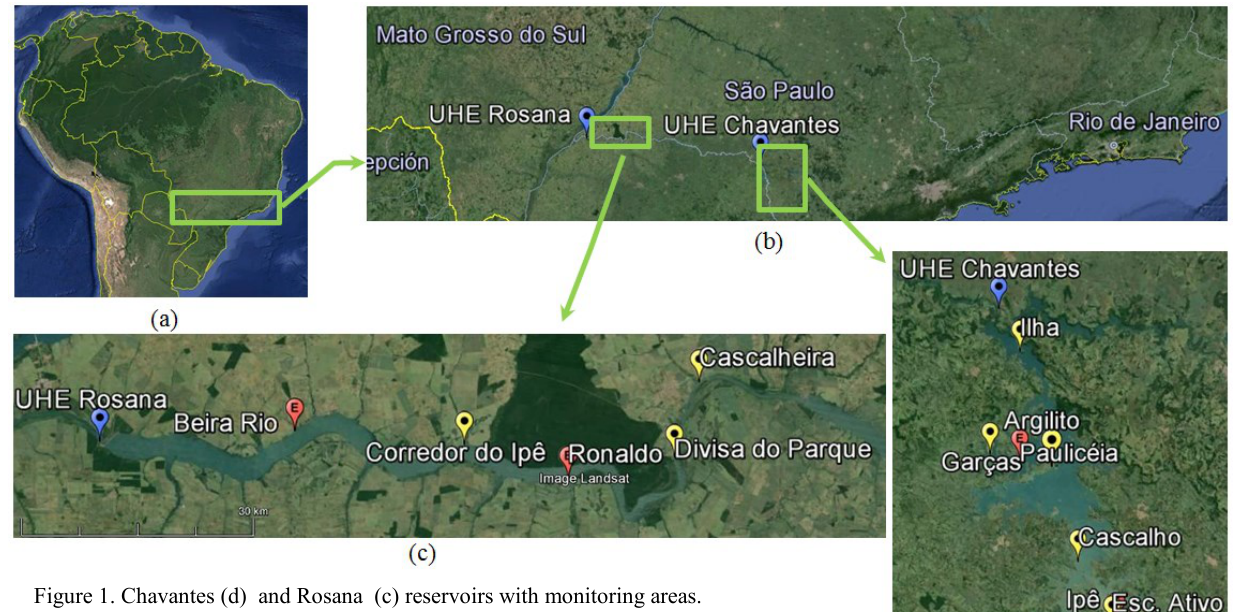
Figure 1. Chavantes (d) and Rosana (c) reservoirs with monitoring areas. Source: Google